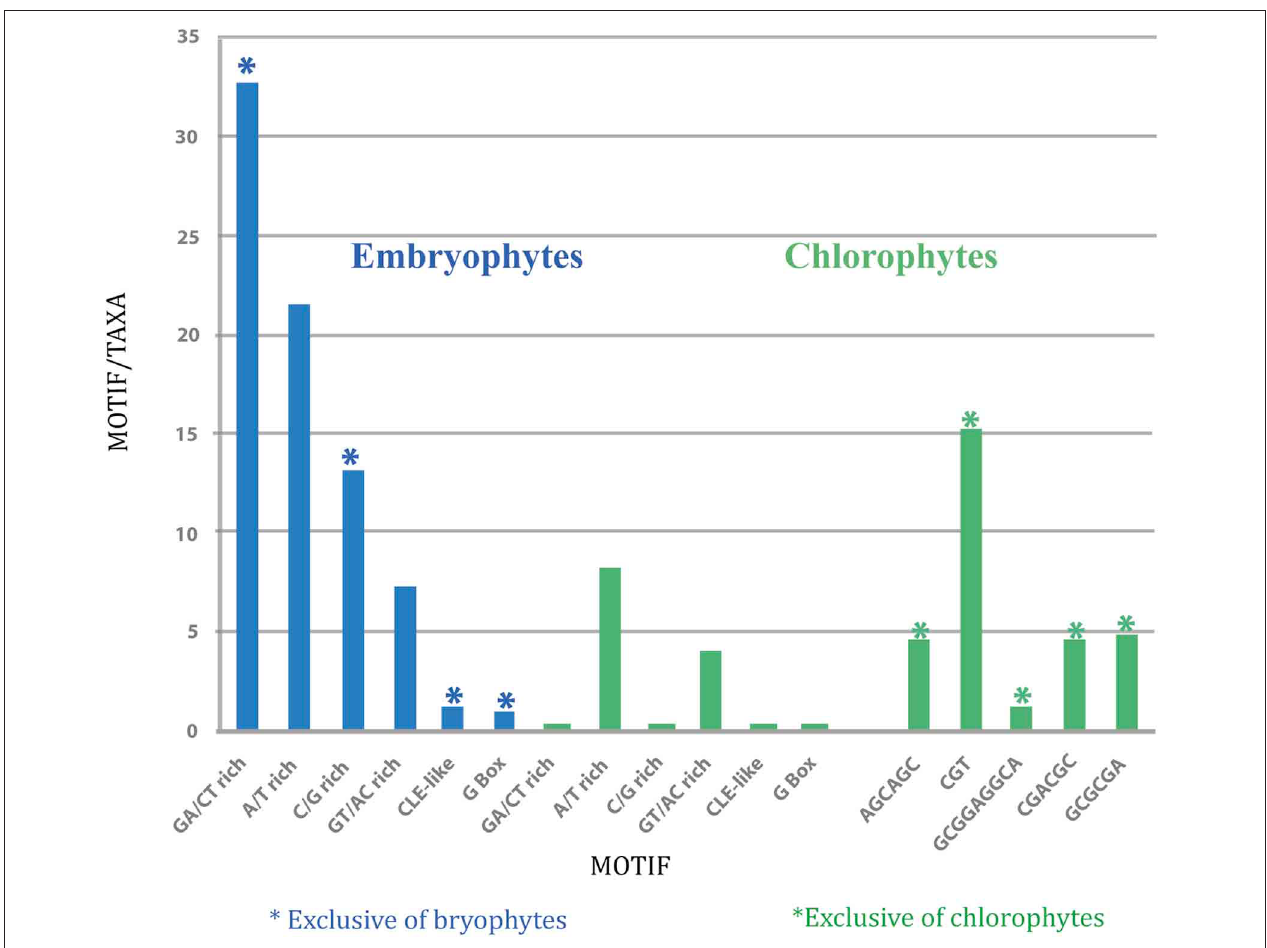
FIGURE 4 | Graphic representation of total number of motifs per total taxa in embryophytes (left; blue), and in chlorophytes (right; green).